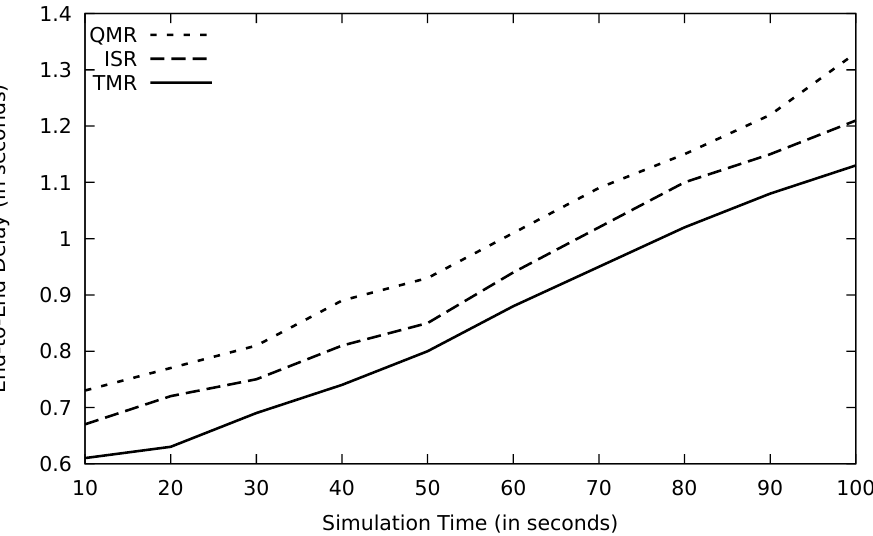
Figure 26. Comparison of EGSR, ISR, and proposed protocol TMR for end-to-end delay with simulation time.